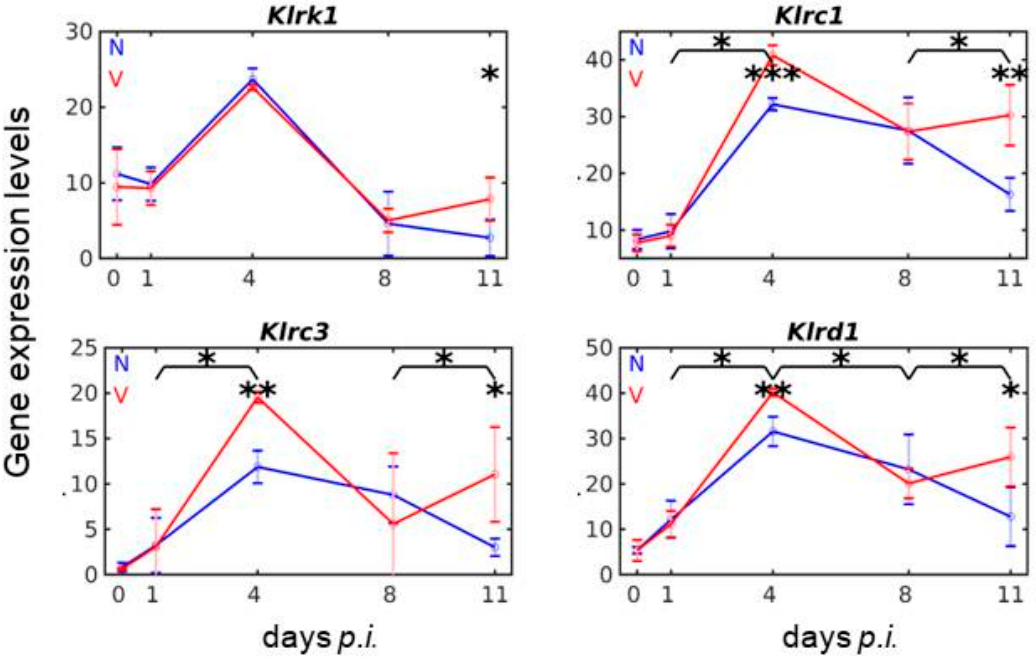
Figure 5. Time series of NK-expressed genes encoding KLR receptors involved in MHCIb-dependent tissue surveillance. RNA was isolated from individual livers prepared from vaccination-protected (V, red) and non-vaccinated (N, blue) mice infected with P. chabaudi blood-stage malaria on days 0, 1, 4, 8, and 11 p.i . Gene expression levels in linear scale are plotted as the means of three microarrays ± SD. The number of “*” marks over interval lines between two sampling points and over a given sampling point indicate statistical significance between two corresponding intervals and between a given sampling point, respectively, between vaccinated and non-vaccinated mice: * p < 0.05; ** p < 0.01; *** p < 0.001.